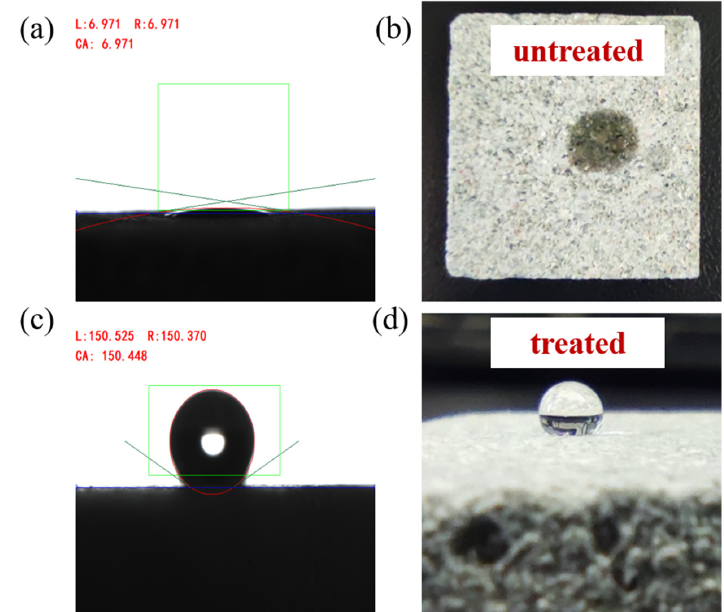
Figure 6. Comparison of wettability of natural cores before and after the nano ‐ emulsion treatment: ( a ) contact angle measurement on the untreated core sheet, ( b ) outlook of a water droplet on the untreated core sheet, ( c ) contact angle measurement on the treated core sheet, ( d ) outlook of a water droplet on the treated core sheet.